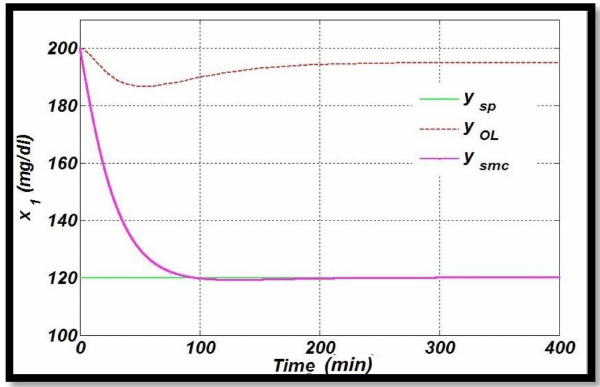
Figure 13. Glucose profile using SMC based on nonlinear